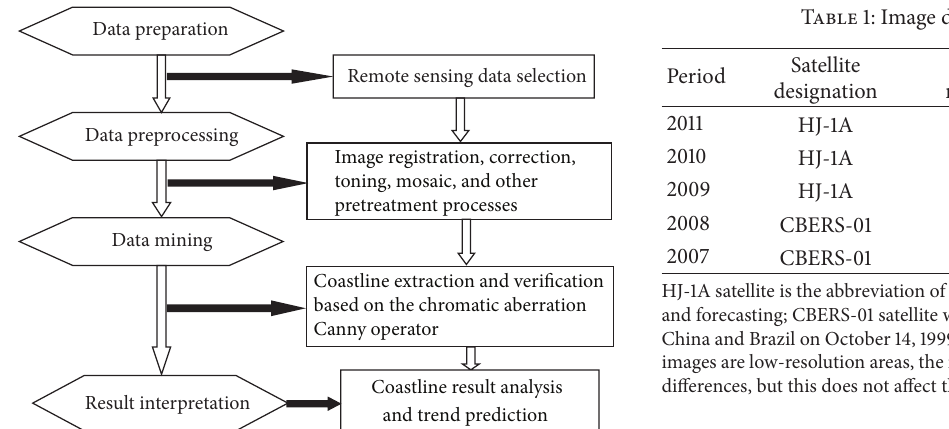
the future variation trend of coastline length by means of grey prediction algorithm to achieve the resulting conclusions and to propose feasible recommendations for the exploitation of the future coastal zone.